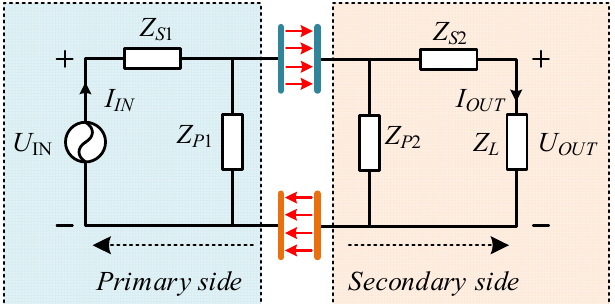
Figure 5. The SP compensation topology in the CPT system.